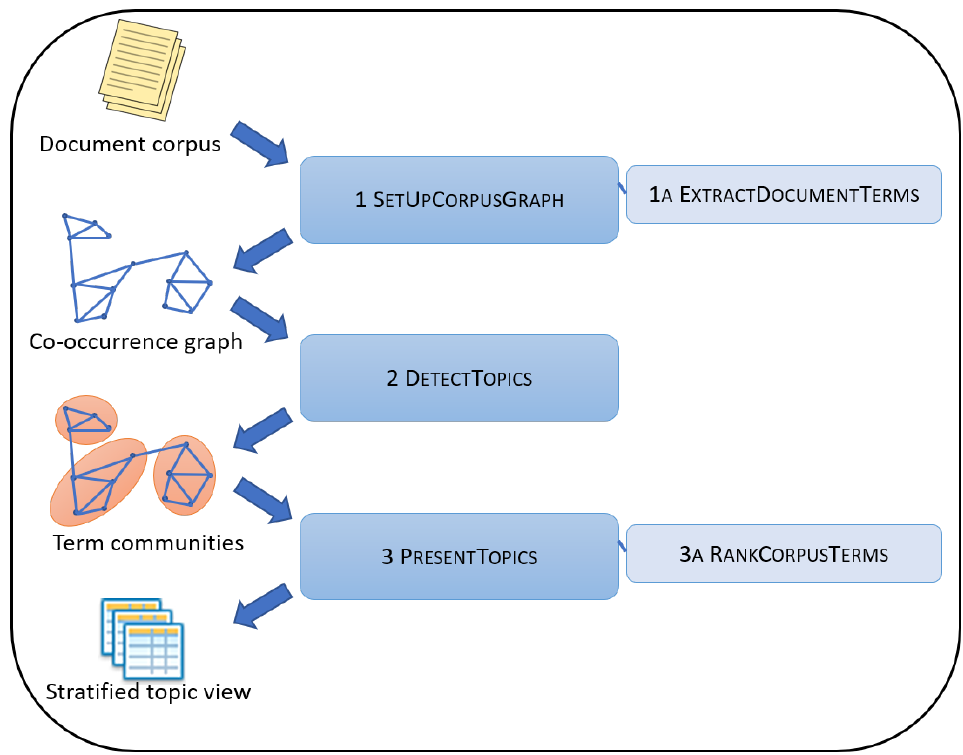
Figure 1. Workflow leading from a corpus of documents to a tabular presentation of topics. The various procedures involved in the workflow are described in detail in Sections